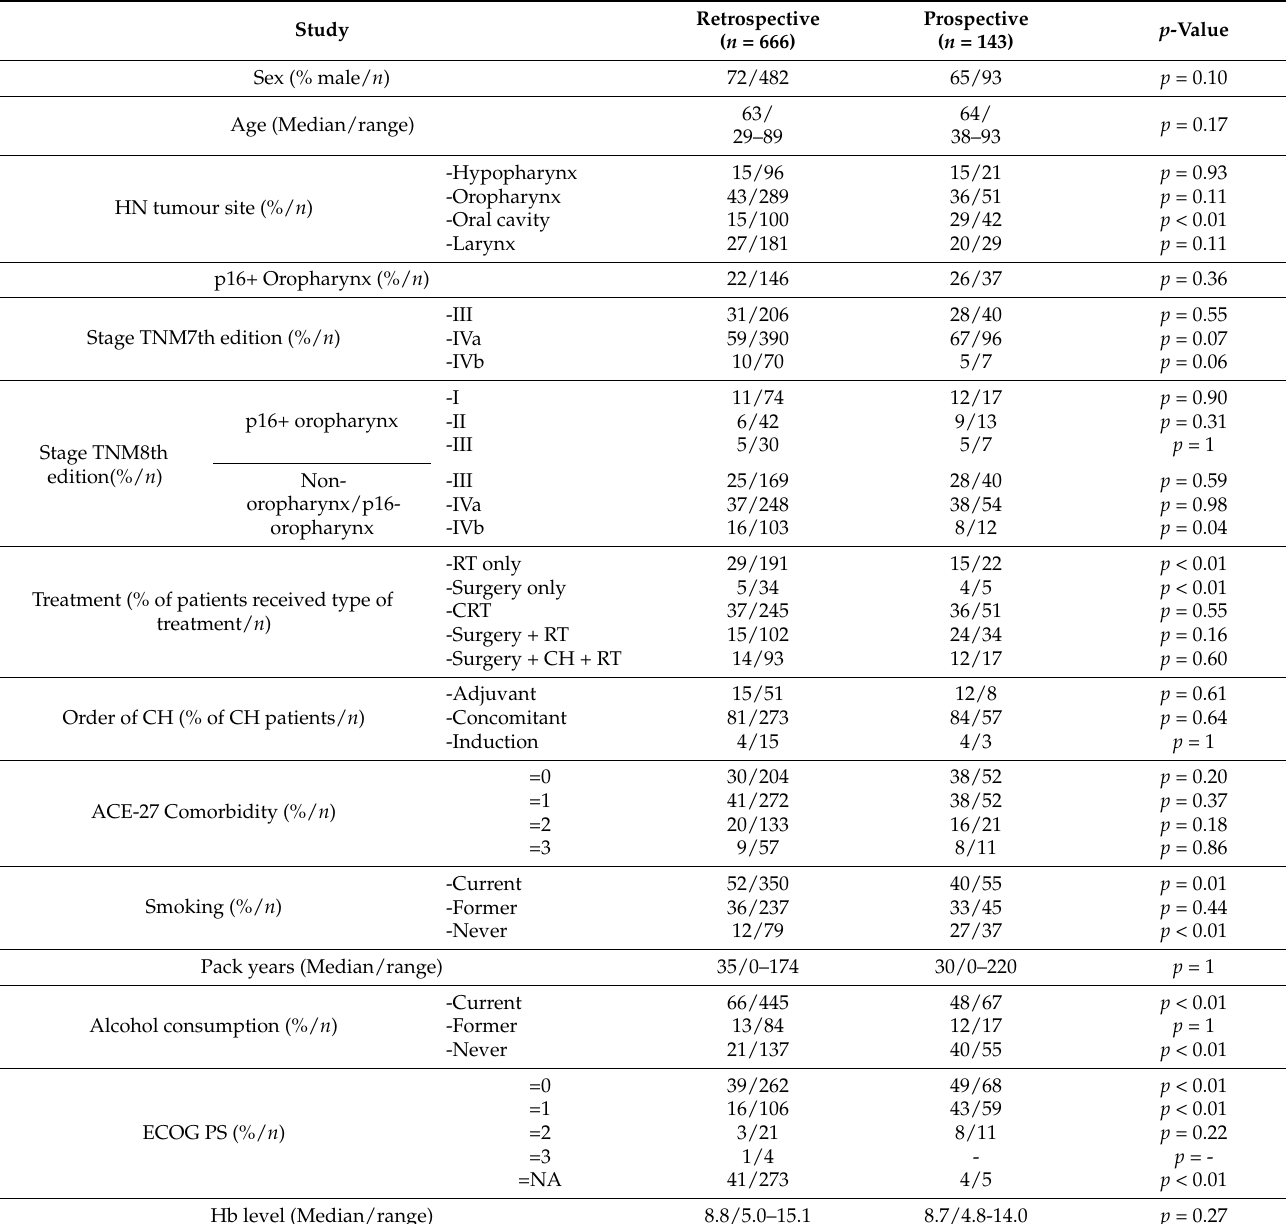
Table 1. Patient characteristics overview for retrospective and prospective patient cohorts. HN = head and neck, RT = radio- therapy, CH = chemotherapy, CRT = chemoradiotherapy, ECOG PS = eastern cooperative oncology group performance